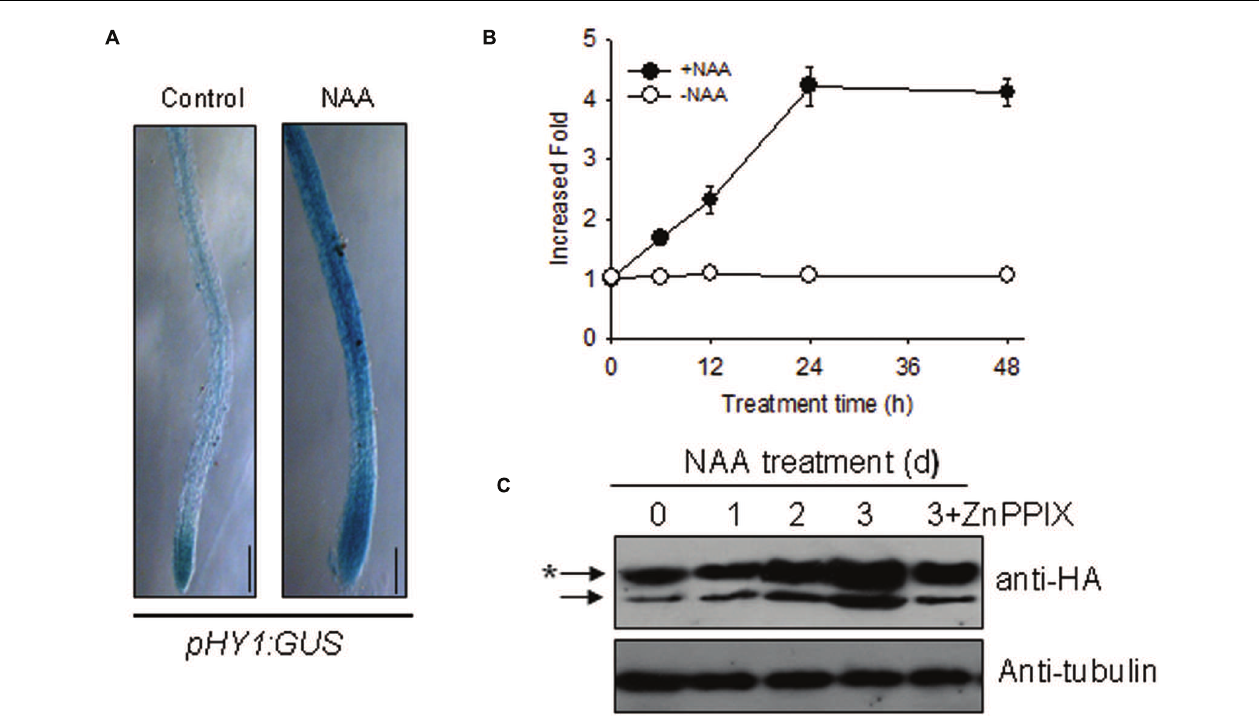
FIGURE 3 | Auxin induced HY1 activity and HY1 -dependent CO generation. (A) Auxin treatment induced GUS expression in the pHY1: GUS transgenic line. Two-week-old pHY1: GUS seedlings were treated with 100 nM NAA for 1 day, and HY1 expression was monitored by GUS staining. Seedlings not exposed to NAA treatment were used as a control. Bar = 0.2 cm. (B) Time-course qRT-PCR analysis of HY1 transcripts abundance after treatment with 100 nM NAA. (C) Auxin induced HY1-HA protein accumulation. Transgenic HY1-OX seedlings (termed HY1-OX) were treated with 100 nM NAA at the indicated time points, and HY1-HA accumulation was analyzed by immunoblot using anti-HA antibody. Blotting with an anti-tubulin antibody was used as a loading control. 3d + ZnPPIX: HY1-OX lines treated with 100 nM NAA plus 200 µ M ZnPPIX for 3 days, before GFP-HY1 accumulation was measured. The asterisk indicates putative post-translational modification